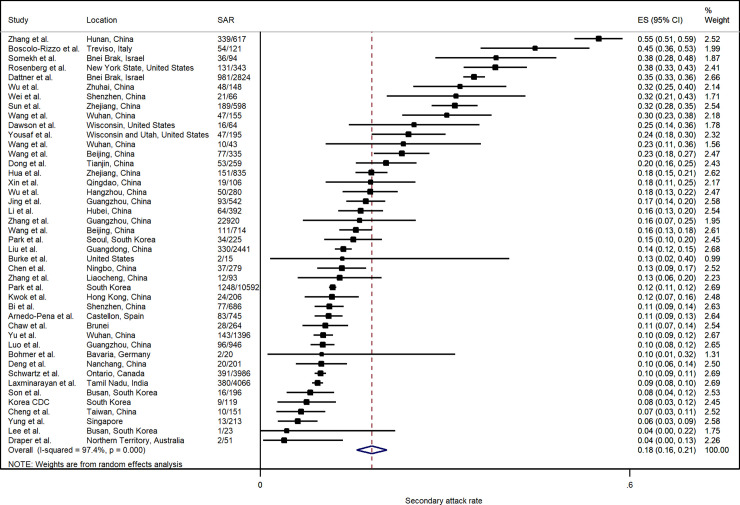
Forest plot of household secondary attack rates (SAR).ES is the estimated SAR, with 95% confidence intervals (CI). I-squared is the percentage of between-study heterogeneity that is attributable to variability in the true effect, rather than sampling variation.